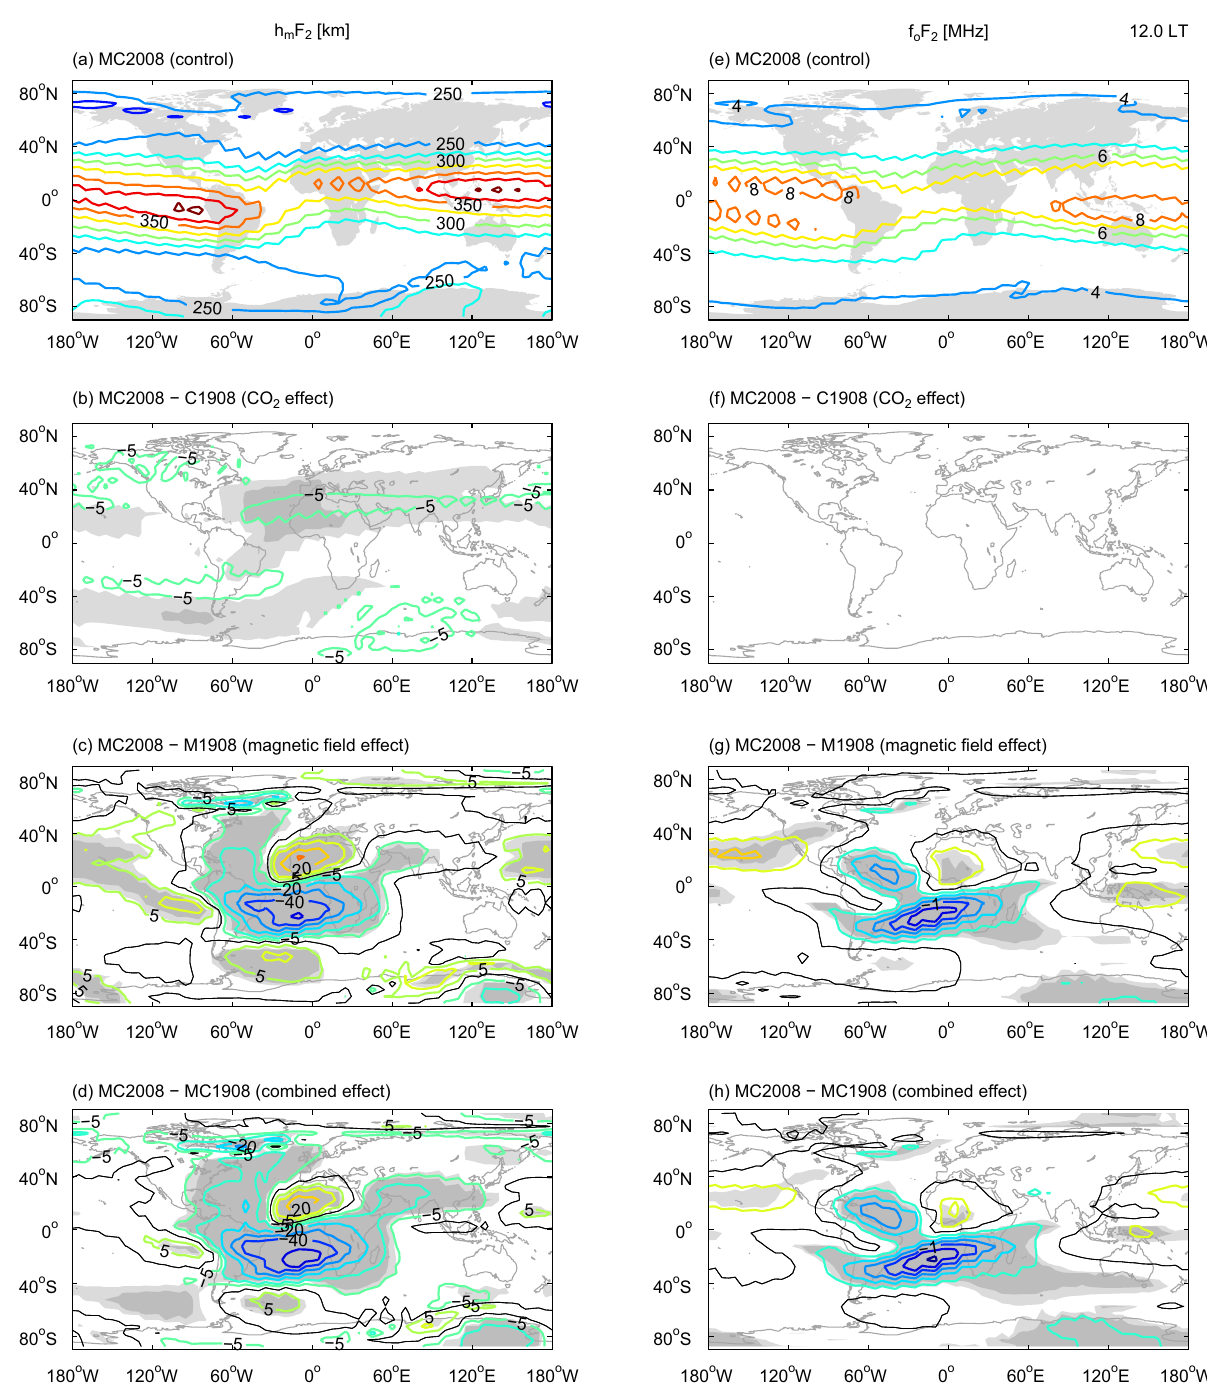
Fig. 3. Sixty-one-day mean h m F 2 (left) and f o F 2 (right) for the control case (MC2008; panels a/e) and the difference with C1908, M1908, and MC1908 (panels b/f, c/g, and d/h, respectively) at 12 LT. The contour interval for the h m F 2 difference plots is 20 km between (cid:2) 60 and +60 km, with additional contours at (cid:2) 5 and +5 km. The contour interval for the f o F 2 difference plots is 0.25 MHz between (cid:2) 1.5 and +1.5 MHz. Light (dark) shading indicates statistical significance at the 95% (99%)